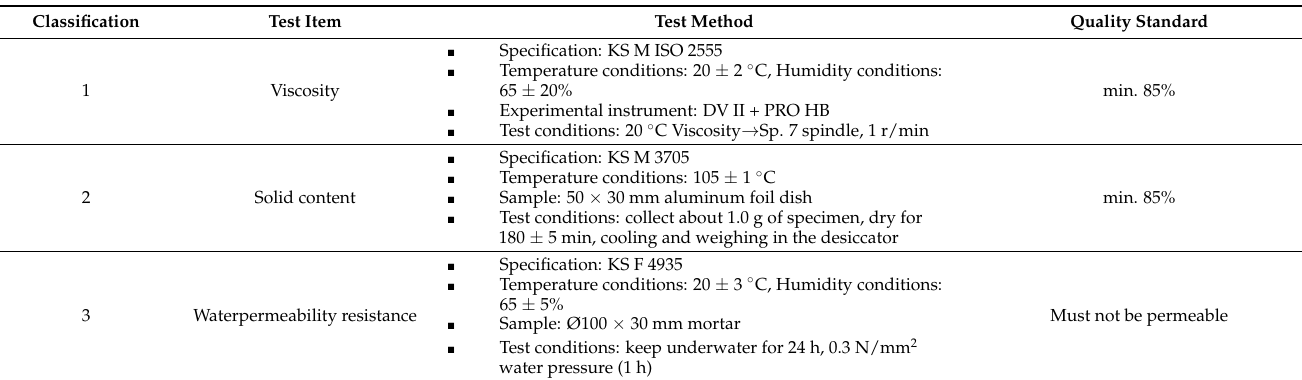
Table 4. Test items and methods for W-SPRG evaluation.